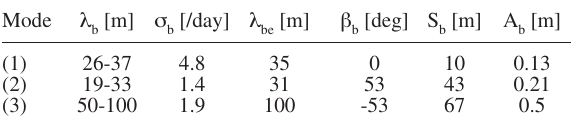
Fig . 8. – Time series of (a) the bed level perturbation h along a longshore section, (b) its Fourier analysis, (c) the bar norm |h|, (d) the dominant wavelength λ , (e) the Fourier coefficient of the corresponding modes b and (f) the growth rate of the corresponding modes s . b Table 3. – Instability modes: wave length λ , growth rate s , wave b b length at the equilibrium state λ , orientation β , protruding dis- be b tance S and amplitude A b b